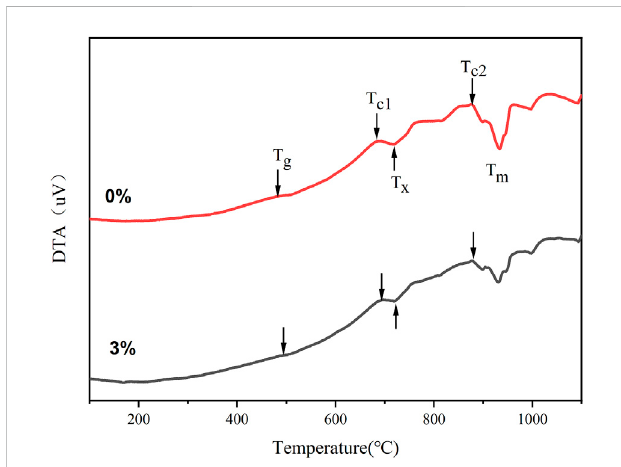
FIGURE 1 DTAcurvesofthebasicglass(0%)andtheglasspowderdopedwith 3 wt% micro-nano-LD whiskers (3%).